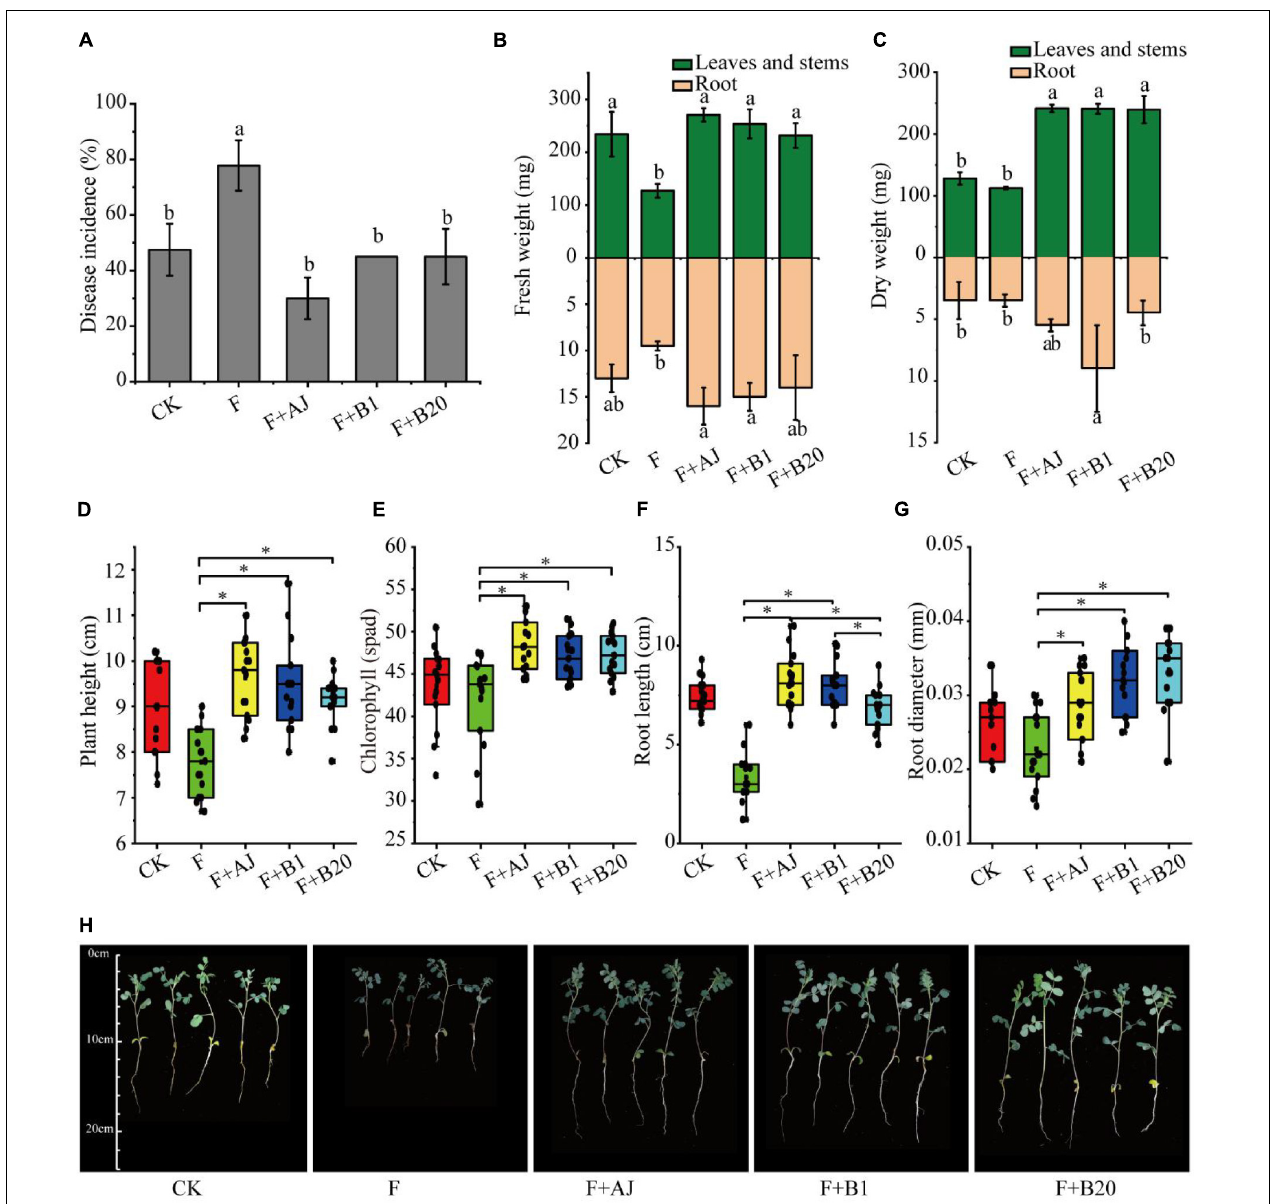
FIGURE 5 | Disease incidence of root rot and growth indexes of Astragalus . (A) Disease incidence of root rot; (B) fresh weight; (C) dry weight; (D) plant height; (E) chlorophyll content; (F) root length; (G) root diameter; (H) growth states of Astragalus in different treatments. CK, no F. oxysporum and no biological control; F, F. oxysporum inoculation alone; F + AJ, F. oxysporum inoculation and 10% AJ control; F + B1, F. oxysporum inoculation and B. velezensis control; F + B20, F. oxysporum inoculation and B. subtilis control. Data are mean ± standard deviation, n = 15. Different letters and the symbol * on the bars indicate statistically significant ( P < 0.05) differences based on Duncan’s